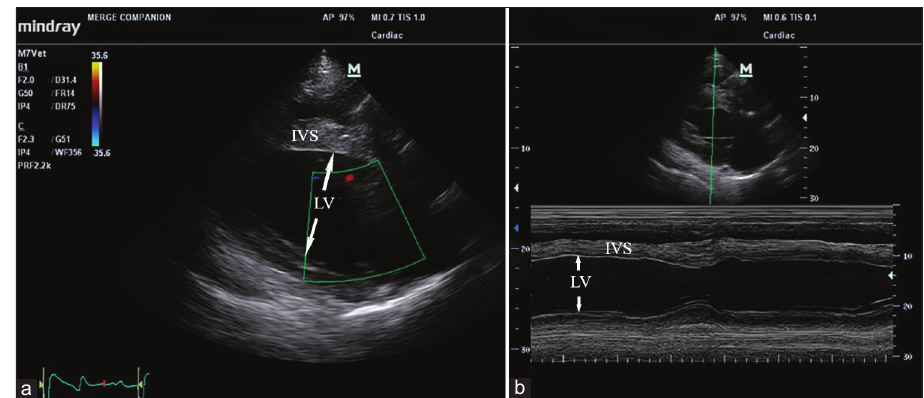
a Figure-3: Echocardiographic of longitudinal image of heart (a) and M mode image of the left ventricle (b), arrow represented the left ventricular internal diameter; LV=left ventricle; IVS=Interventricular septum. Table-4: Mean electrical axis parameters in two lead systems. Lead system